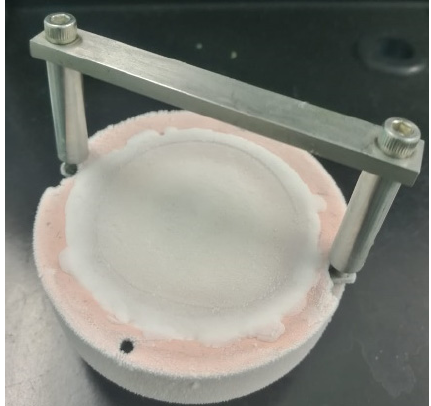
Figure 7. Photographs of frozen material used as matrix-assisted pulsed laser evaporation (MAPLE) target.